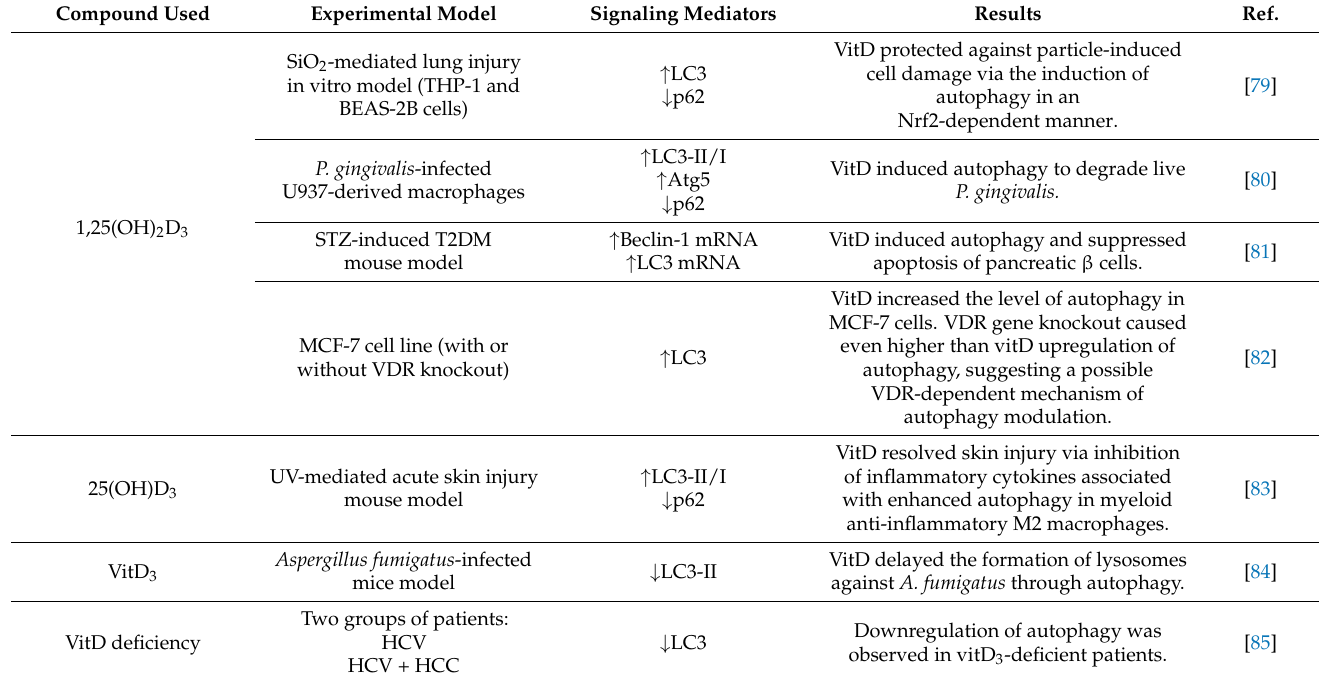
Table 3. Summary of selected available reports on the modulation of autophagy by vitamin D and its